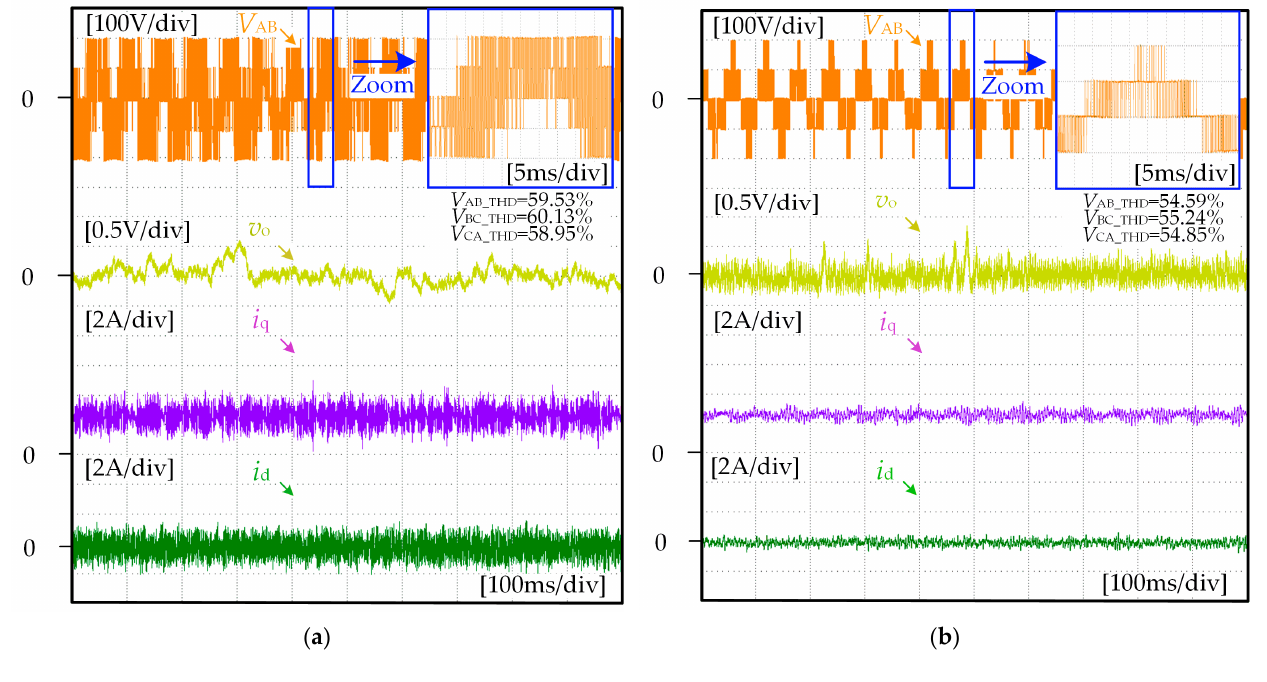
Figure 11. Steady-state performance at 500 r/min 2 N · m. ( a ) Traditional MPCC strategy; ( b ) Pro- posing ECS-MPCC strategy.